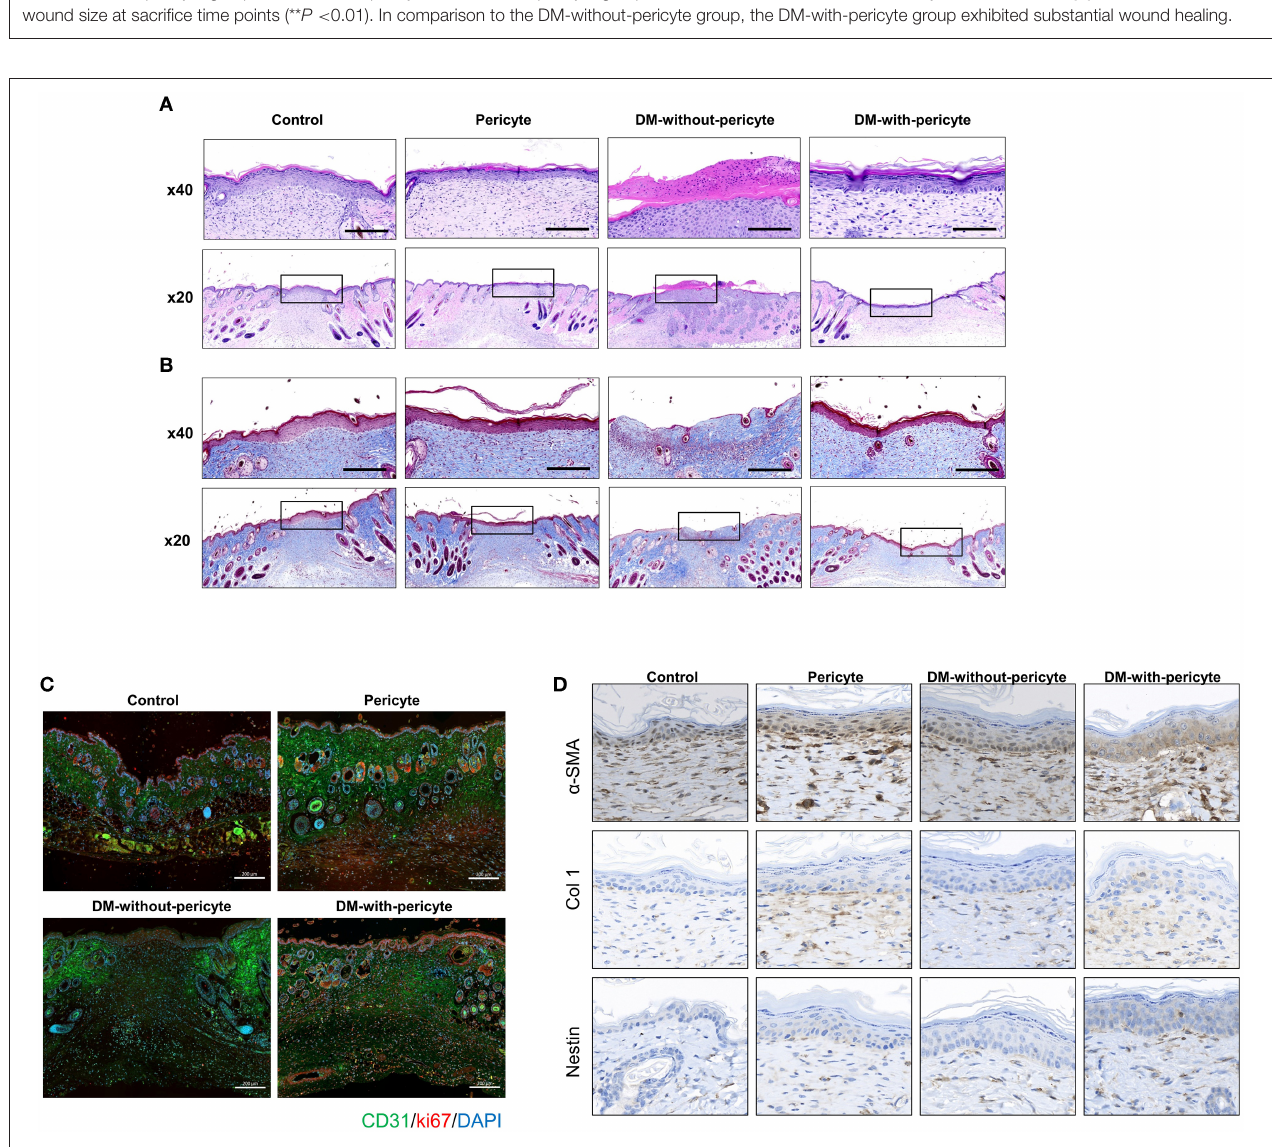
FIGURE 4 | The DM-with-pericyte group showed successful repair of the collagen layer and higher blood vessel formation capacity compared to the DM-without-pericyte group. (A) H&E staining. (B) Masson’s trichrome staining for wound analysis at 14 days. The black square indicates the regenerated dermal collagen layer. Scale bars = 200 µ m. (C) CD31 and Ki67 immunofluorescence of wounds at 14 days. In diabetes wounds, new vessels were significantly less visible than in normal mice. However, when diabetic mice were injected with pericytes, new vessels were observed more often. (D) α -smooth muscle actin ( α -SMA), collagen 1 (Col 1), and Nestin immunohistochemistry of wounds at 14 day. Scale bar = 50 µ